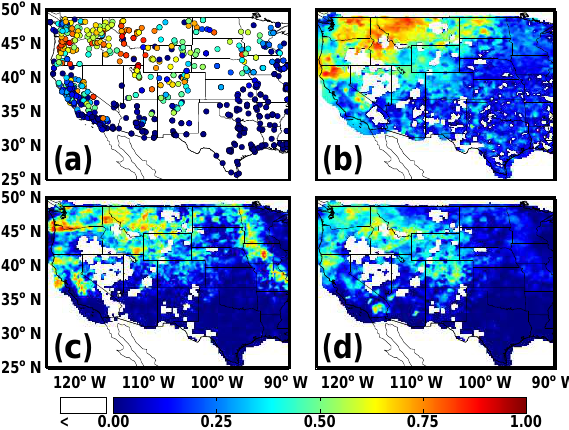
Figure 3. R 2 values for % of Facebook posters and (a) surface mea- surements of PM 2 . 5 (for sites with >35 days of measurements), (b) WRF-Chem PM 2 . 5 , (c) MODIS AOD when cloud fraction was below 0.75, and (d) HMS smoke product for the period of 5 June to 30 September